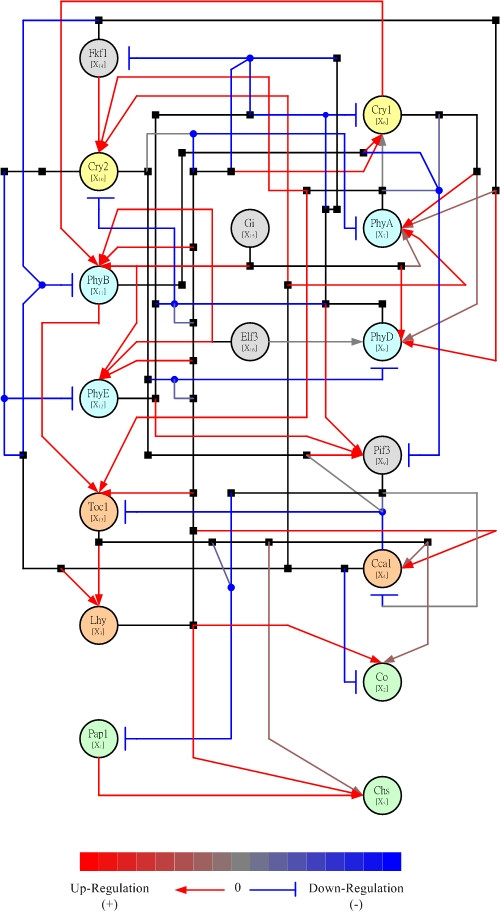
The pathway of circadian regulatory system of Arabidopsis thaliana in Fig. 5 is repeated as independent validation by randomly reshuffling the time order of microarray experiment but with the same choices of target and regulatory genes. Obviously, the proposed pathway in Fig. 5 is destroyed by the reshuffling of experimental data. The related genes are represented as ovals with different colors of light yellow (crytochrome), light blue (phytochrome), orange (biological clock genes), light green (some physiologically light-dependent downstream genes), and gray (other relevant genes not as target genes). There are three types of lines with colors of red (activation), blue (repression), and black. In addition to the black line representing the signal pipes from genes, the red lines are shown depending on the degree of activation whilst the blue lines are shown depending on the degree of repression. The black square symbol attached on the lines is the bifurcate node from the same pipe of signal. The circle symbol attached on the lines is the collecting nodes from different signal sources. The colored degree bar between activation and repression is also shown in the bottom of the figure.